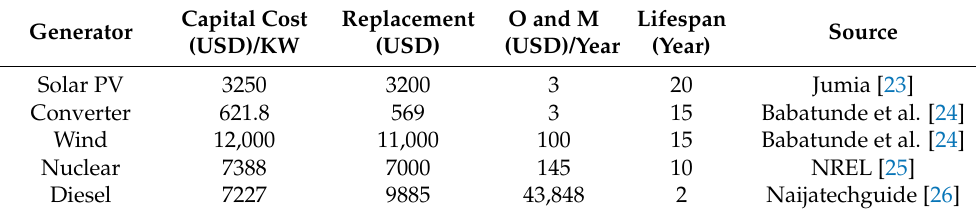
Table 1. Energy resource parameters.